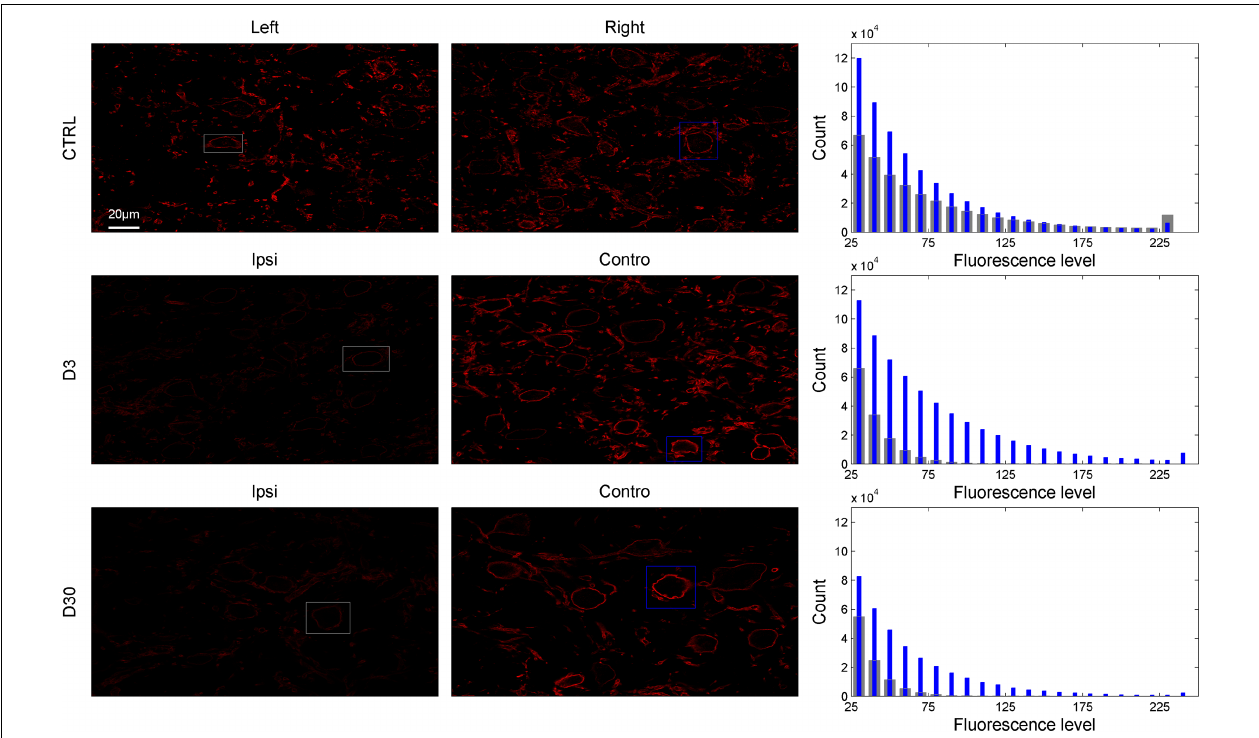
FIGURE 6 | Examples of entire slices showing KCC2-related fluorescence in control and lesioned animals (D3 and D30 post-lesion) in the left and right VCN (or VCN ipsilateral and contralateral side to the lesion; first and second column). The corresponding distribution of fluorescence from the slices is shown in the third column (gray bars: left or ipsilateral to the lesion, blue bars: right or contralateral to the lesion). The region of interests delineated by gray and blue rectangles in the first and second columns are showed in Figure 7 at higher magnification.